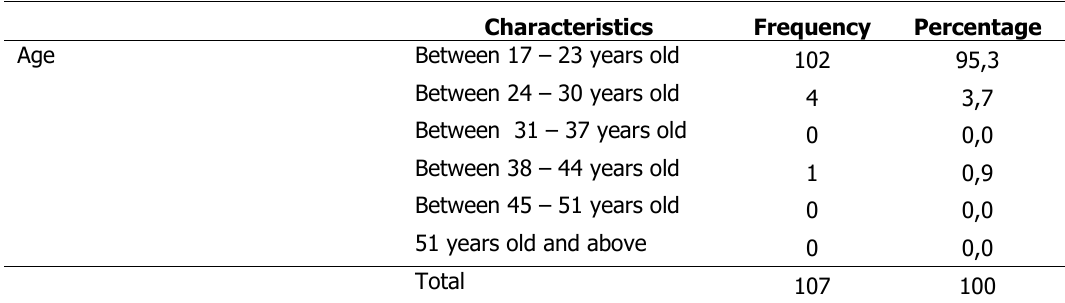
Table 2. Demographic Characteristics of Observations Based on Age